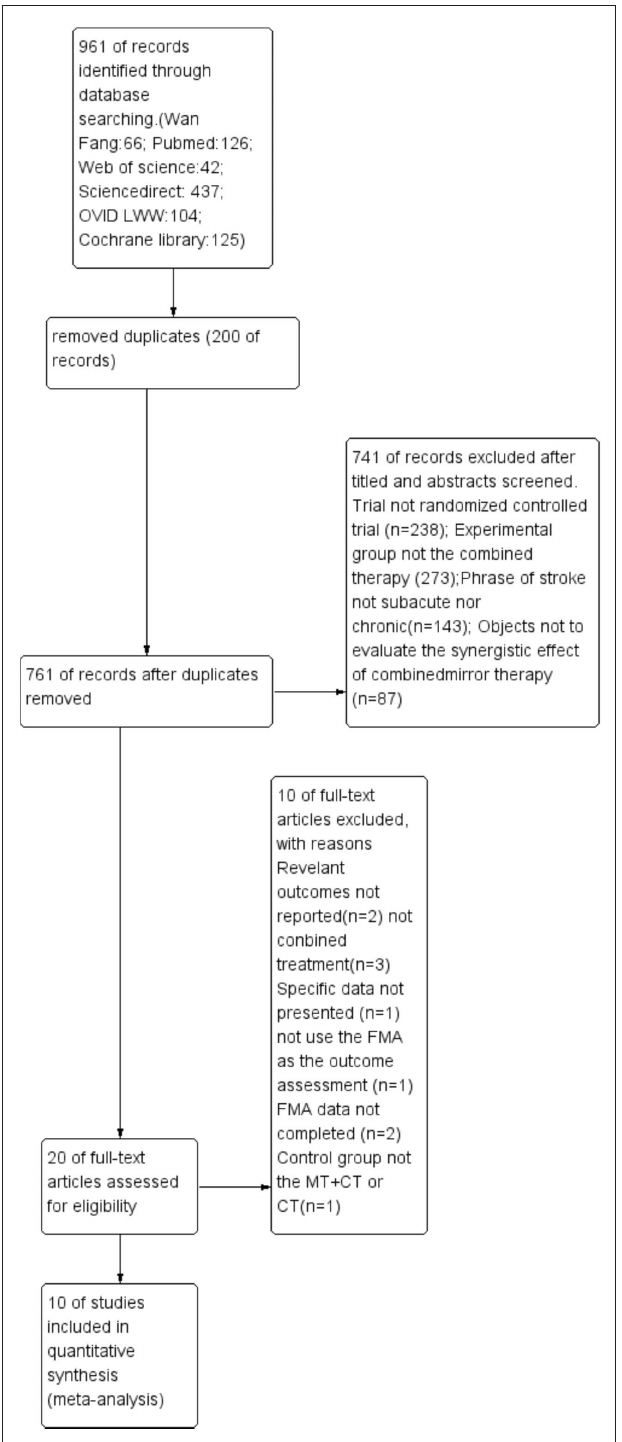
FIGURE 1 | Literature search and study selection. FMA: Fugl-Meyer Assessment; MT: mirror therapy; CT: combined therapy. 1,920 min. Figure 2 presents the authors’ judgments about the risks of bias for the included studies. All studies (10, 21, 31–33, 43–47) described the methods used to generate the allocation